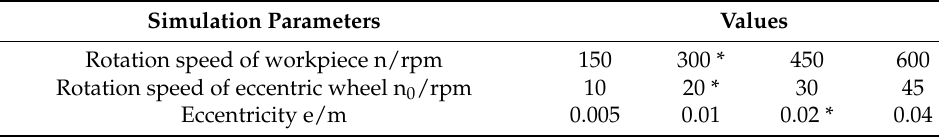
Table 2. Simulation parameters of reciprocating motion.